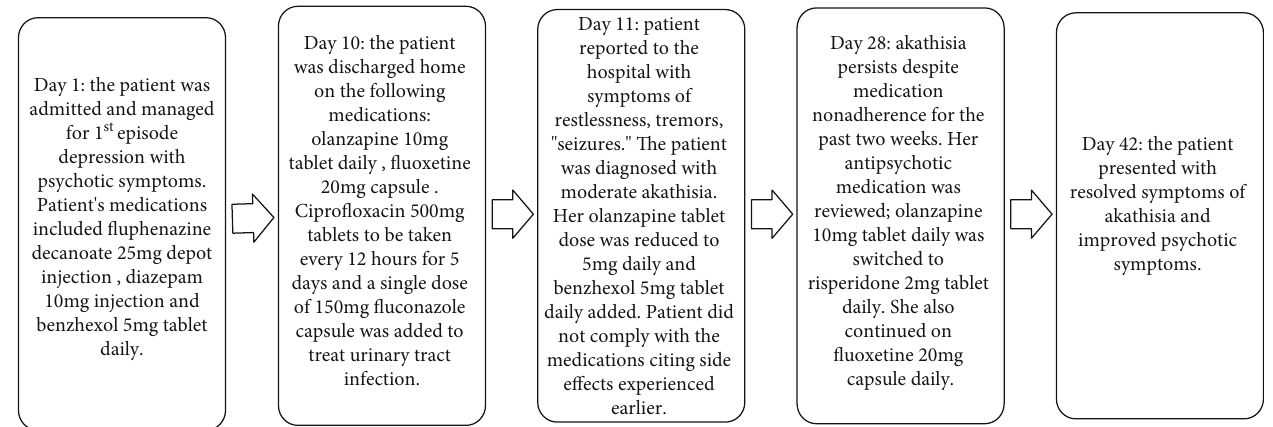
Figure 2: A description of the temporal association between Case B ’ s presentation, treatment, and resolution of Table 1: Result of Naranjo Adverse Drug Reaction Probability Scale for Case A and Case B. Question